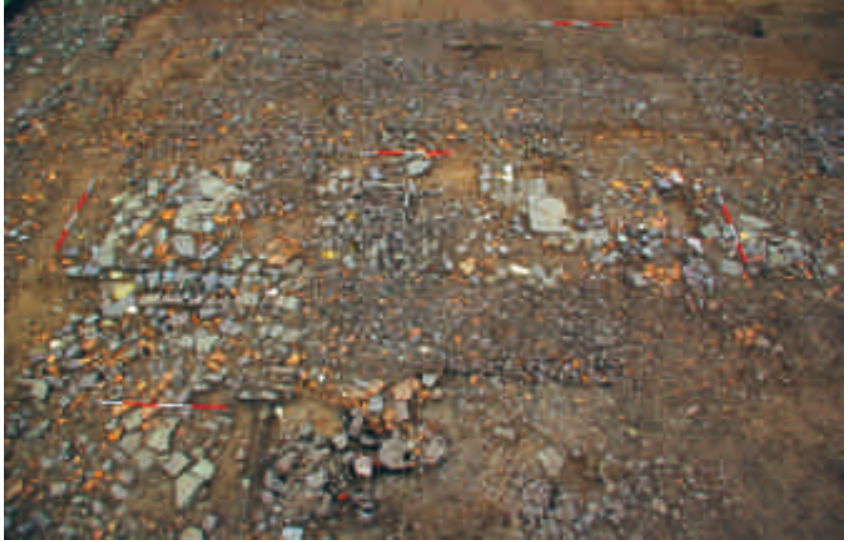
Figure 7 The flagged area of the Medieval barn